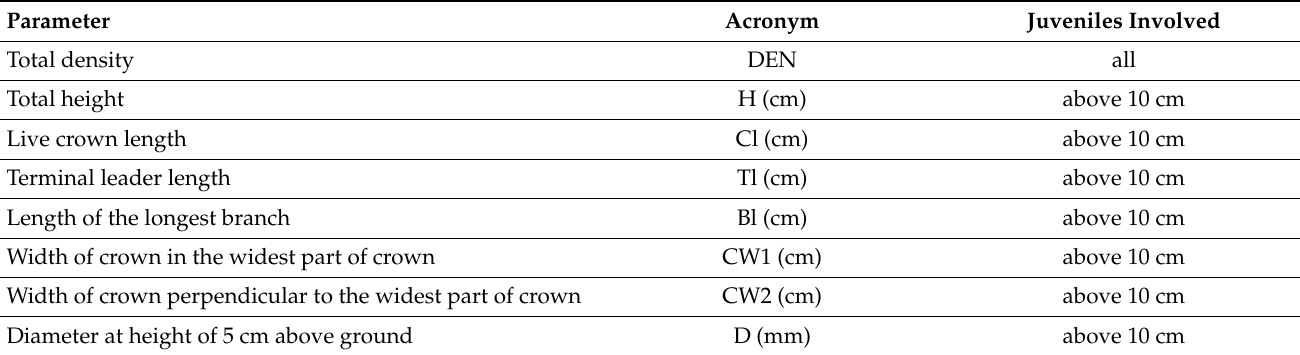
Table 2. Parameters of Norway spruce natural regeneration that were measured within the